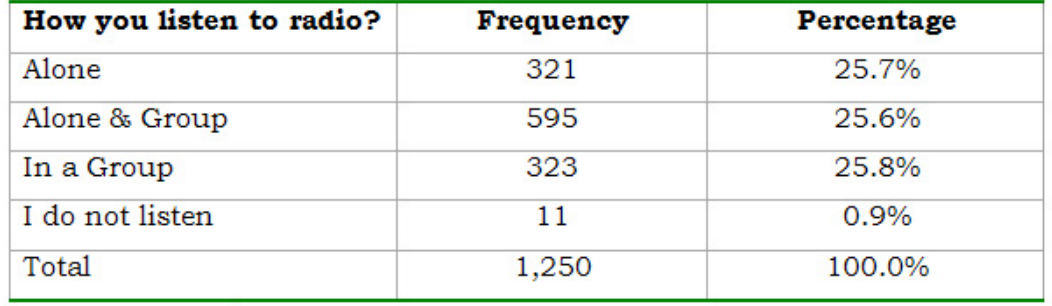
Table 6. Mode of radio listening in